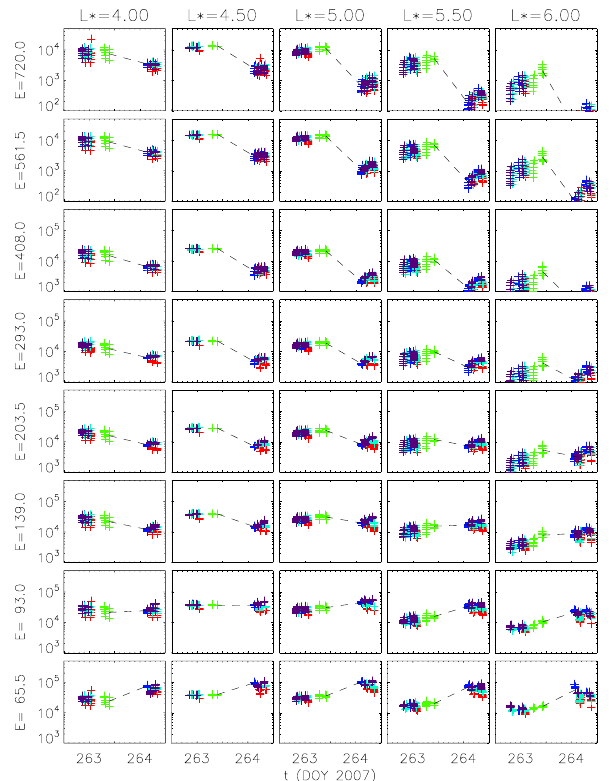
Figure 4. Particle fluxes just before and after the dropout. The color coding denotes the individual spacecraft as in the previous figure. The slopes of the dotted lines were used to determine timescales.